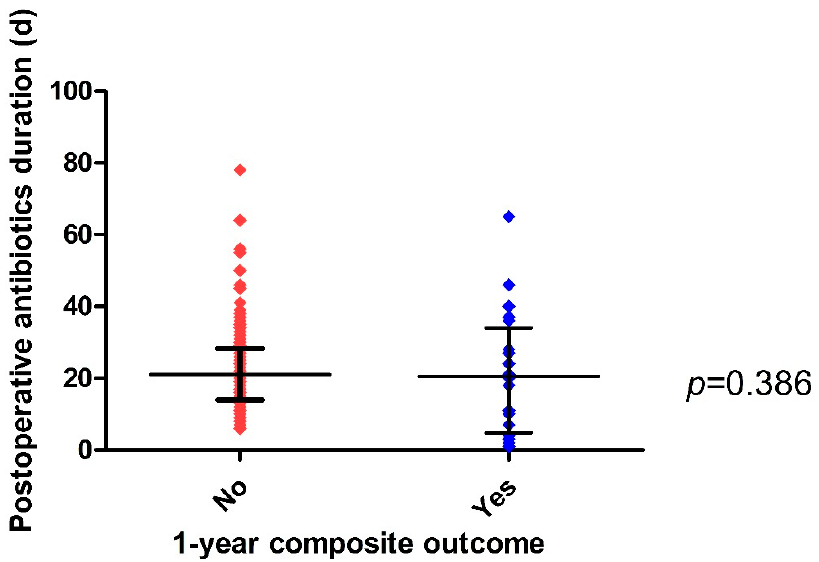
Figure 3. Scatter plot of postoperative antibiotic treatment duration according to the 1-year composite outcome in patients with infective endocarditis who underwent valve surgery.